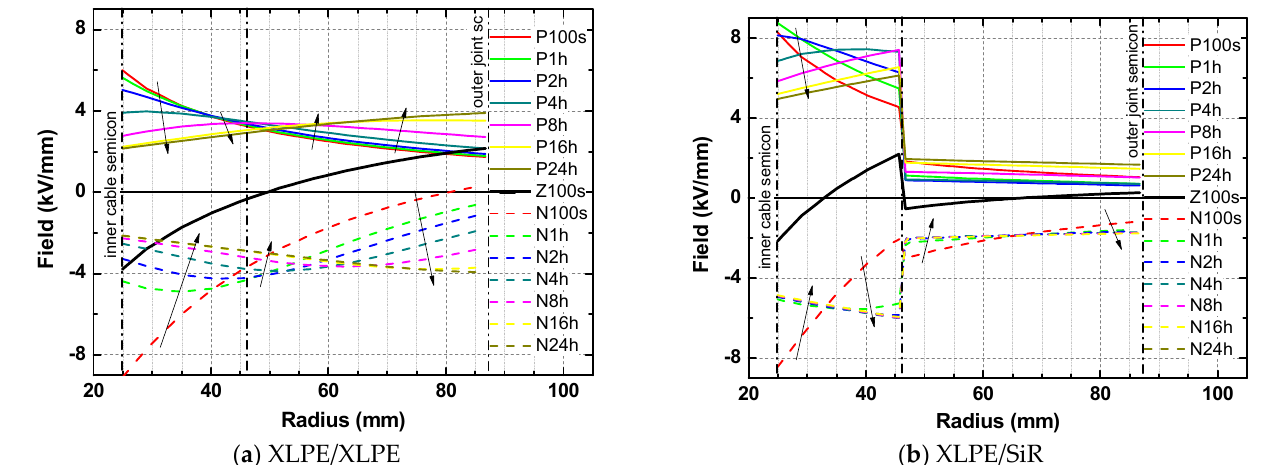
Figure 7. Radial field distribution at different times after voltage application for ( a ) XLPE/XLPE joint and ( b ) XLPE/SiR joint under non-stationary thermal gradient. Same conventions as in Figure 6.